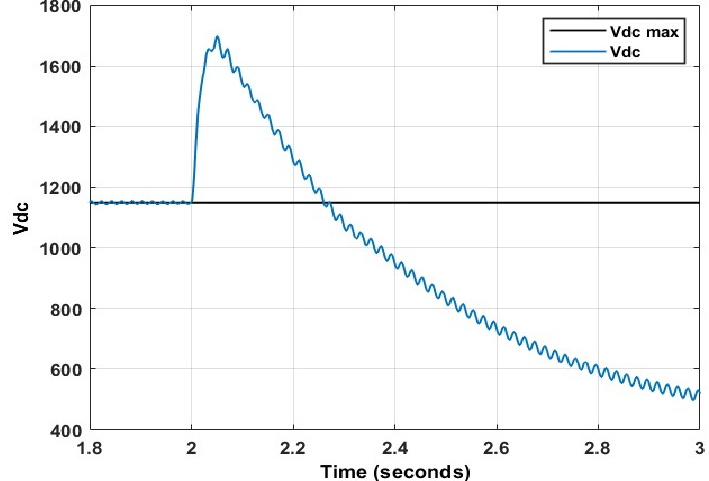
Figure 20. DC voltage transient using AVOA at 90% dip.